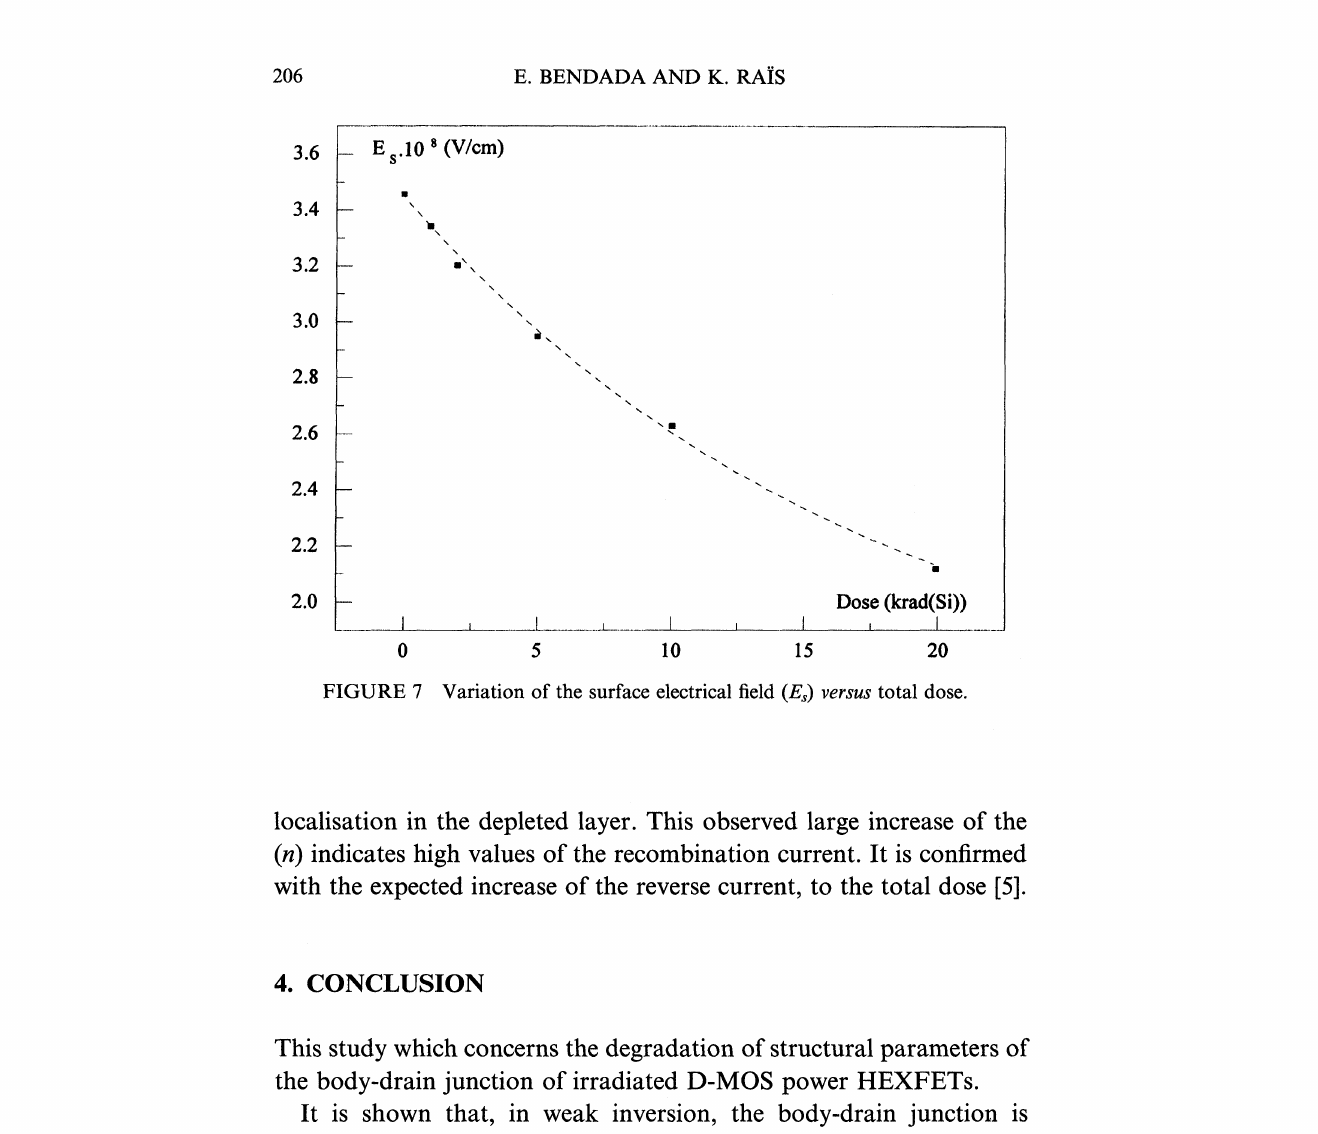
FIGURE 7 Variation of the surface electrical field (E,) versus total